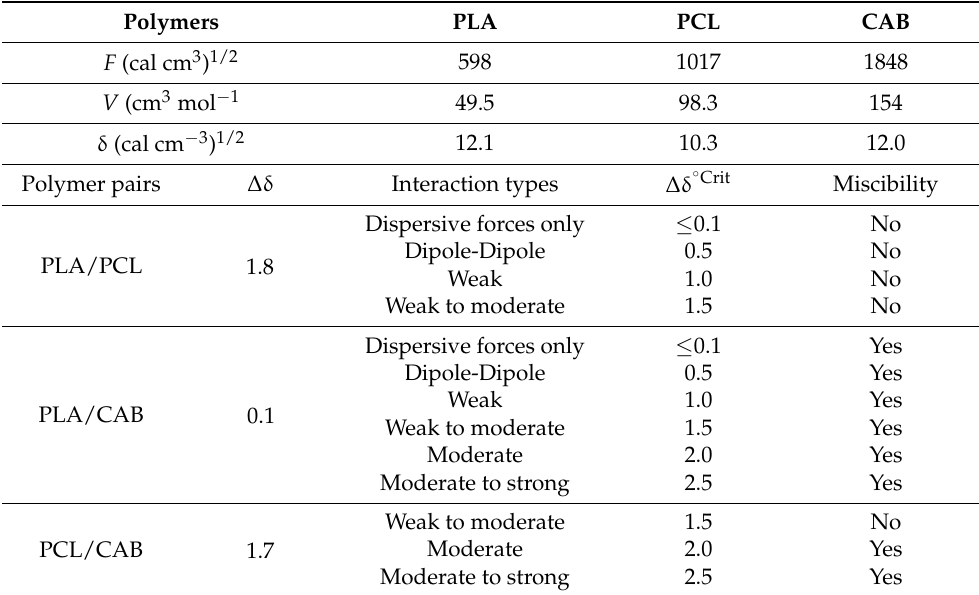
Table 1. Miscibility prediction of polymer pairs of PLA/PCL, PLA/CAB and PCL/CAB using critical solubility parameter differences [( ∆ δ ) ◦ Crit ] from the Coleman and Painter approach, showing molar attraction constants (F) and molar volumes (V) together with derived critical solubility parameter differences ( ∆ δ )